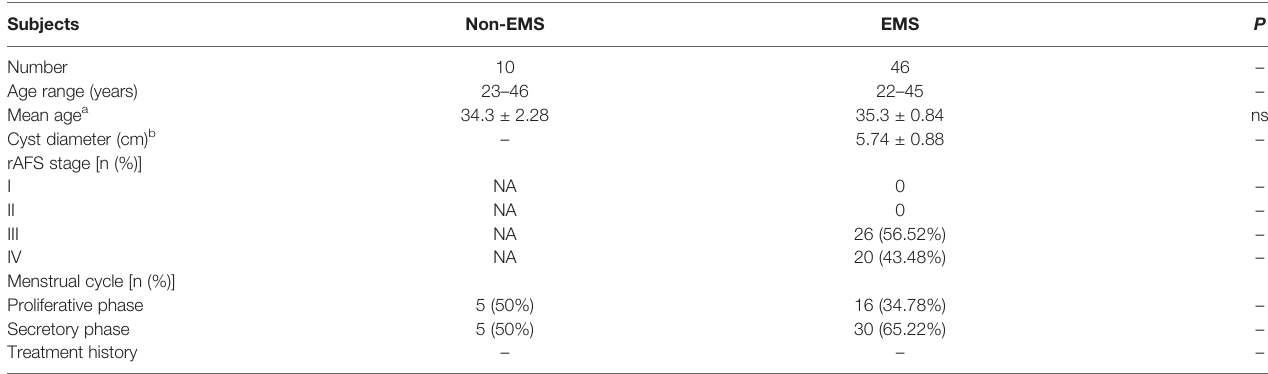
TABLE 1 | Characteristics of the study